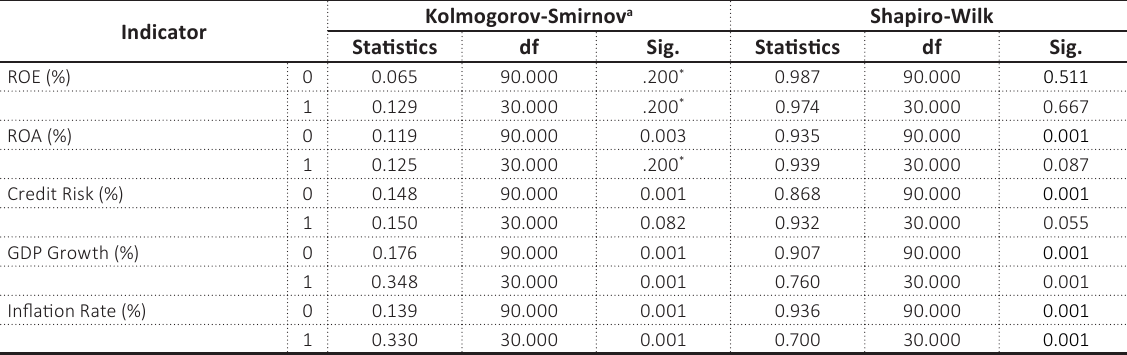
Table 4. Normality test – Indonesia vs Malaysia Indicator